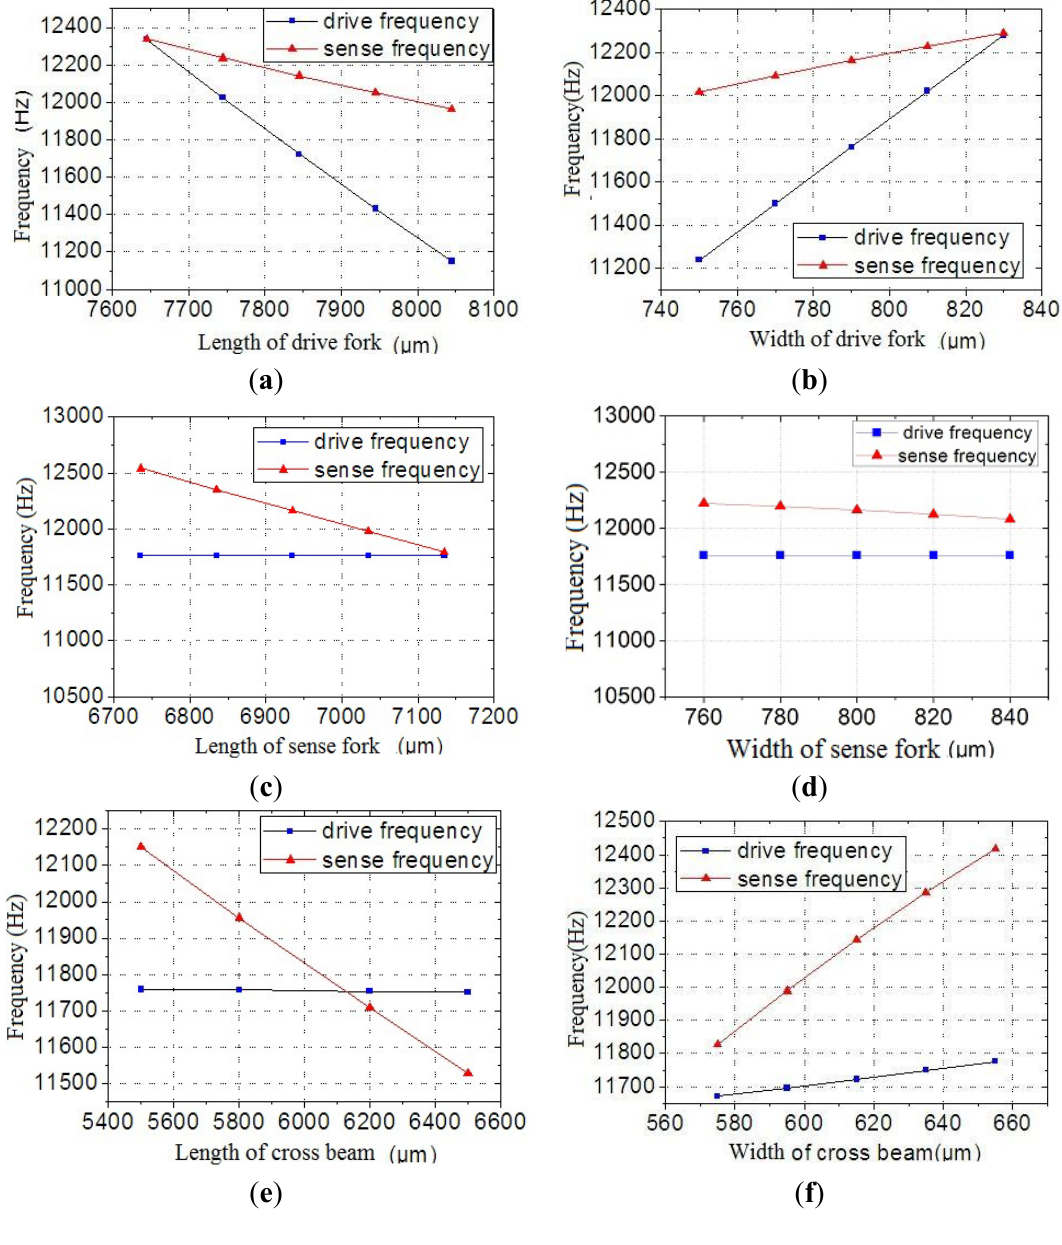
Figure 6. The effect of different fork dimension on the frequency. ( a ) Frequencies versus length of drive fork; ( b ) Frequencies versus width of drive fork; ( c ) Frequencies versus length of sense fork; ( d ) Frequencies versus width of sense fork; ( e ) Frequencies versus length of cross beam, and ( f ) Frequencies versus width of cross